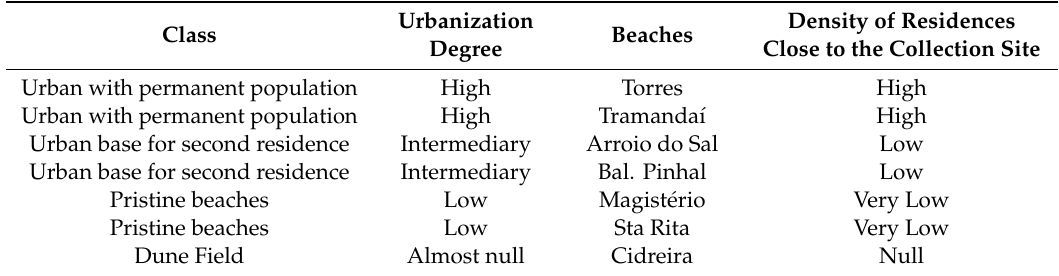
Figure 1. Geographic location of the seven northern Rio Grande do Sul beaches where the study was developed. Red dots = high degree of urbanization, yellow dots = intermediary degree, green dots = low degree, blue dot = almost null urbanization. Table 1. Urban development classification and density of residences near the collection site for the beaches from northern Rio Grande do Sul state (RS), Brazil.